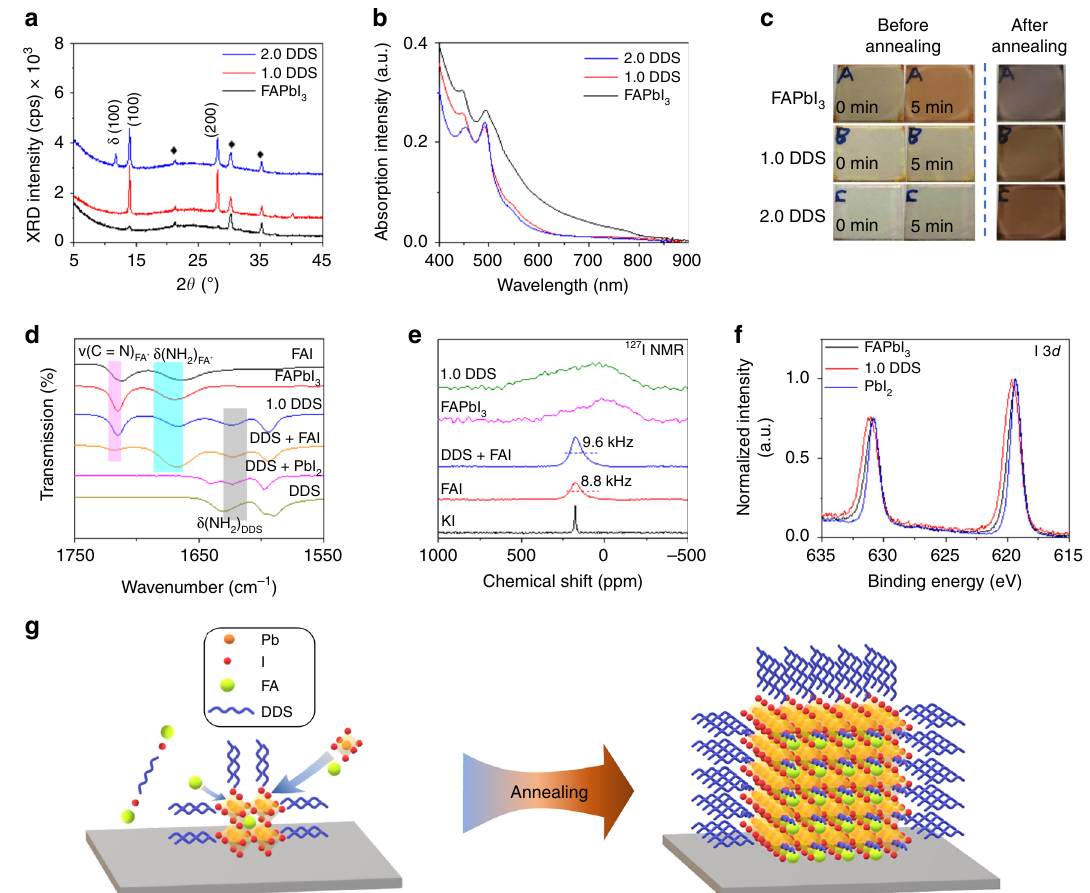
Fig. 3 Crystal growth mechanism of PMC thin fi lms. a XRD patterns (diffraction peaks from the ITO substrate are marked as ♦ ) and b absorption spectra of perovskite fi lms before annealing. c The photographs of perovskite fi lms before and after annealing. d FTIR spectra of annealed FAPbI 3 , 1.0 DDS fi lms, and their raw materials. e The experimental 127 I NMR spectra of KI, FAI, FAI + DDS, FAPbI 3 , and 1.0 DDS fi lms. f X-ray photoelectron spectroscopy (XPS) of I 3d peak of annealed PbI 2 , FAPbI 3 , and 1.0 DDS fi lms. g Schematic illustration of the growth mechanism of PMC thin fi